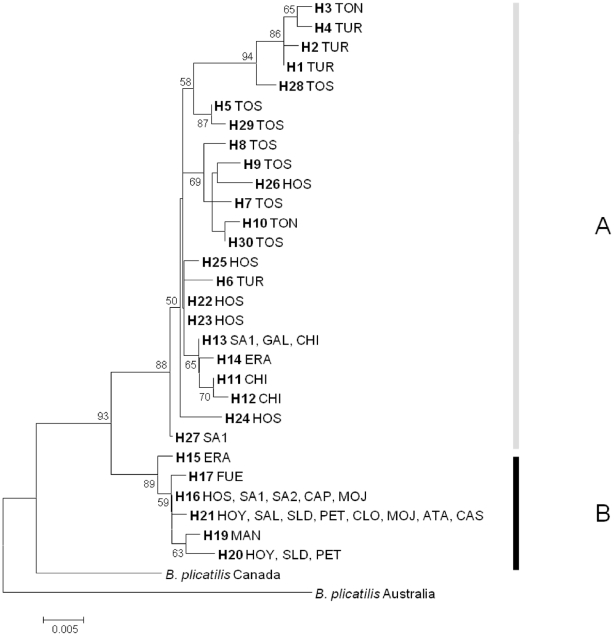
Midpoint rooted maximum likelihood phylogram of B. plicatilis mtDNA haplotypes.Percent bootstrap support, if >50%, is shown. See Table 1 for pond acronyms.